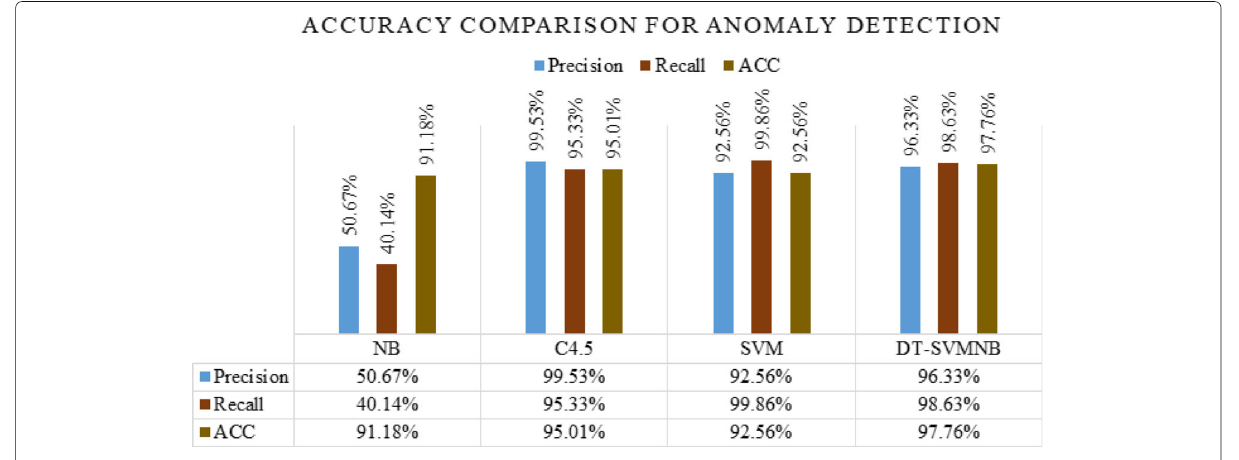
Fig. 5 Anomalous Suicidal User detection Accuracy